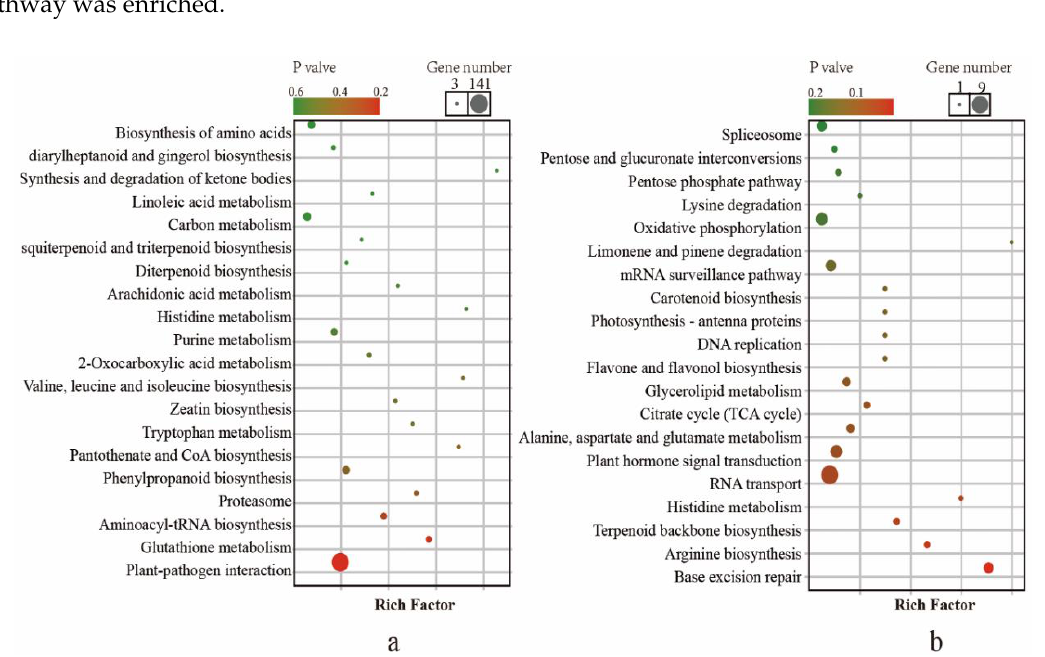
Figure 3. KEGG pathway enrichment for differential gene expression among F1 hybrids and its parents. ( a ) KEGG analysis of gene with a higher-parent dominance pattern. ( b ) KEGG analysis of gene with an over-parent dominance pattern.